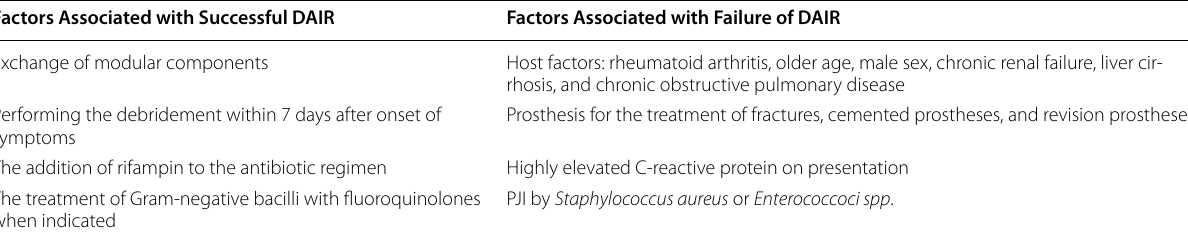
Prosthesis for the treatment of fractures, cemented prostheses, and revision prostheses PJI by Staphylococcus aureus or Enterococcoci spp